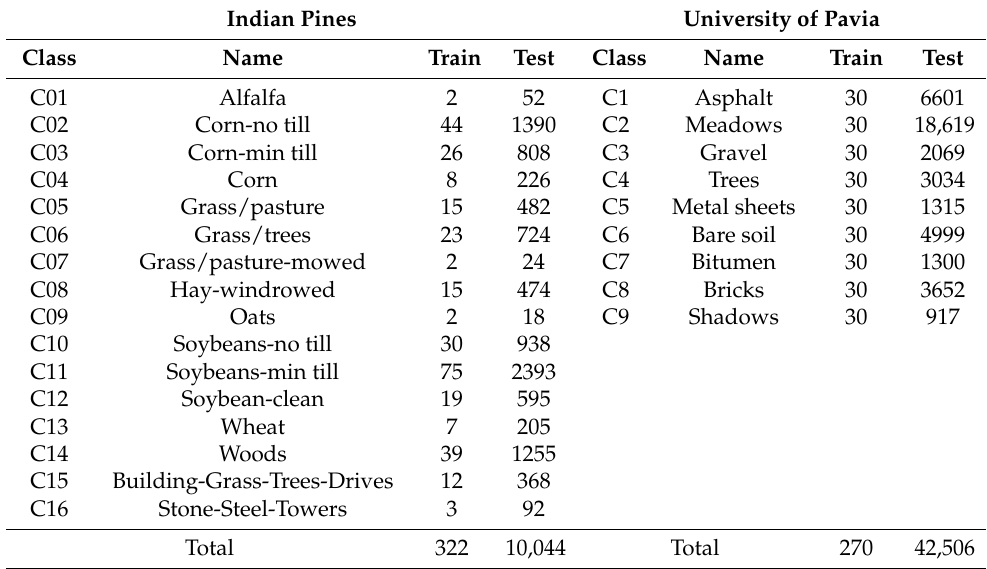
Table 1. The number of training and test samples in two real hyperspectral image (HSI)